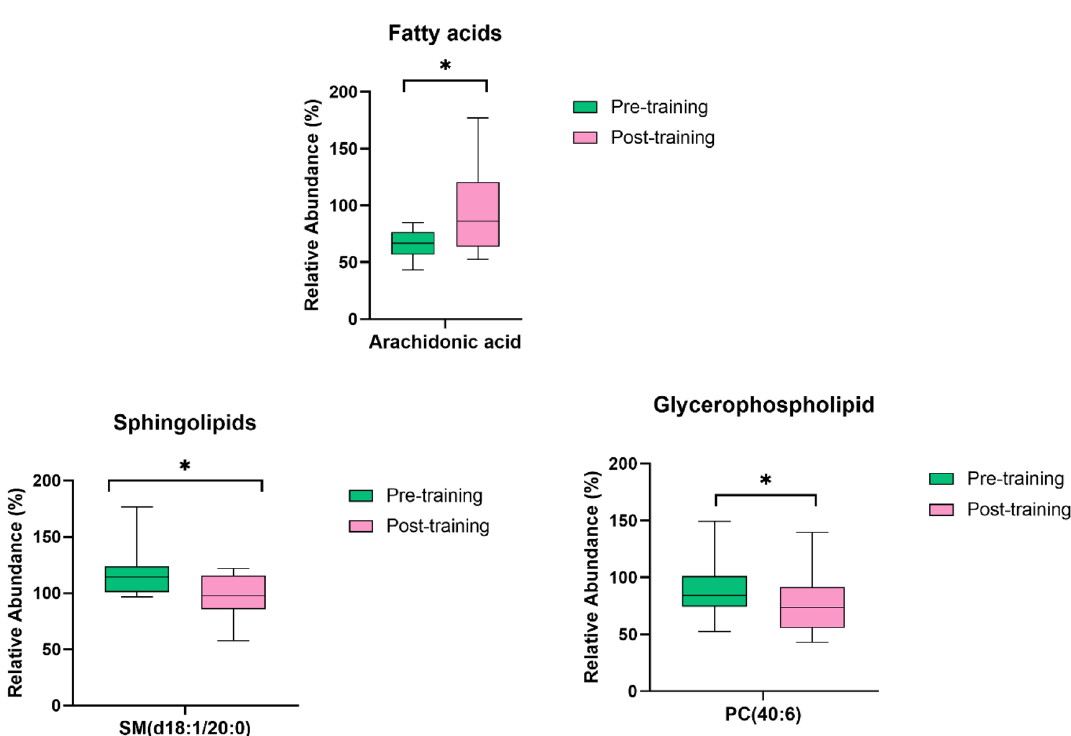
Figure 2. Boxplot of the 3 significantly altered lipids sorted by lipid class with significant differences (* p < 0.05). Green represents the pre-training, and pink represents the post-training intervention. The y-axis is the relative abundance (%). The x-axis corresponds to is each lipid